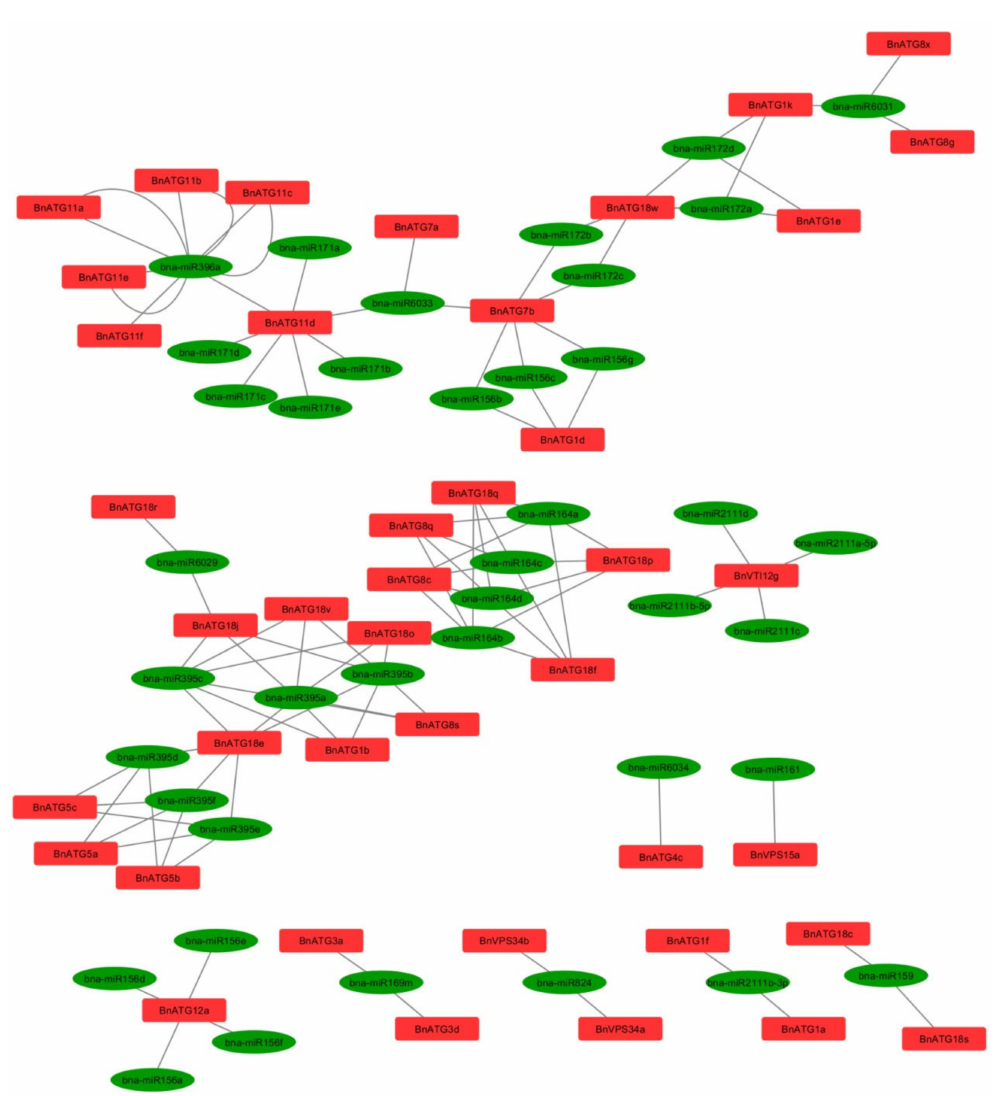
Figure 9. An miRNA-gene network based on interactions between miRNAs and BnATGs . Green ellipses represent miRNAs and red rectangles denote